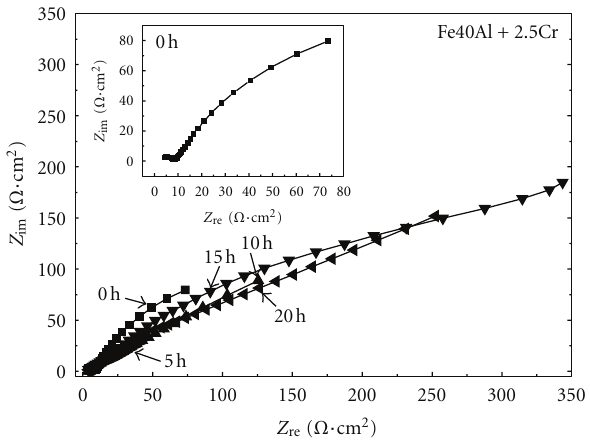
Figure 8: Nyquist diagrams for Fe40Al + 2.5Ti in the KCl + ZnCl 2 mixture at 670 ◦